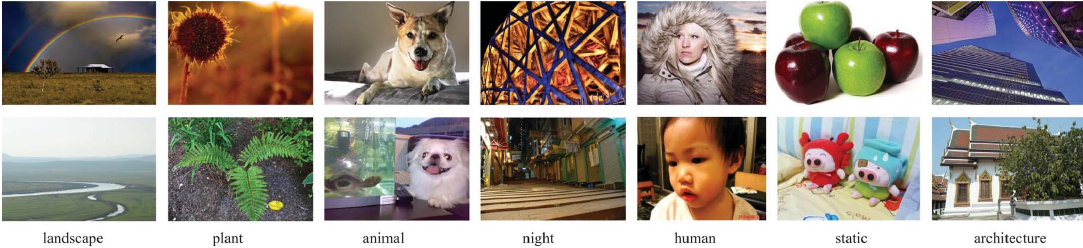
Figure 4. Several images contained in the Chinese University of Hong Kong-PhotoQuality (CUHK-PQ) dataset [81,101]. Many distinctive differences can be visually observed between the high-quality and low-quality